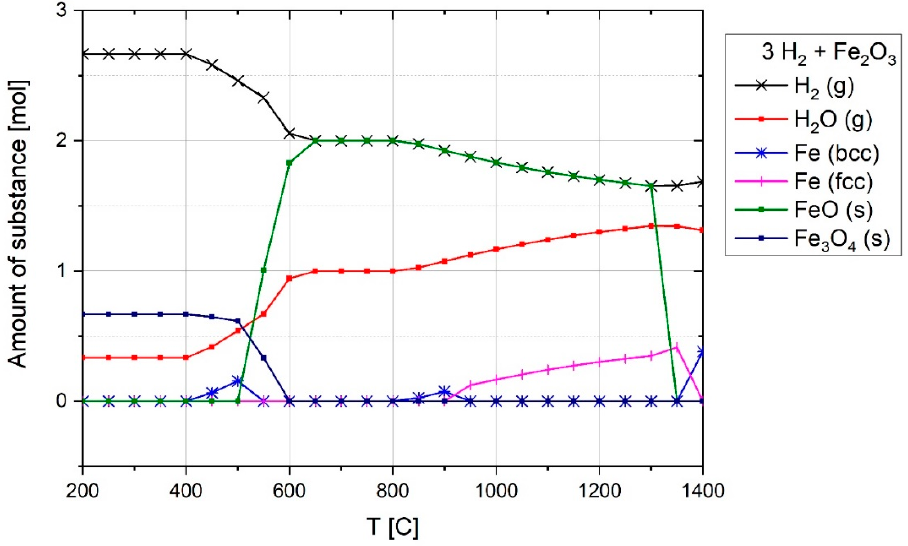
Figure 13. Chemical composition of 3 mol H 2 and 1 mol Fe 2 O 3 at equilibrium and 1 atm pressure.